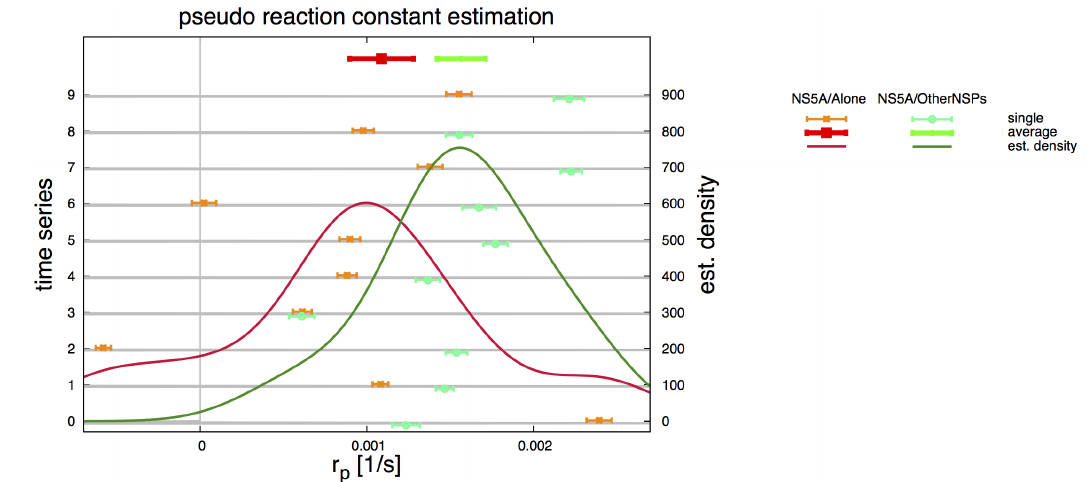
Figure 2. Averages for pseudo reaction rate r p —analyzed separately for NS5A/Alone (red— r A p ) and NS5A/OtherNSPs (green— r N p ). Thin points and error bars correspond to estimated values for r p (shown on x axis) for a single TMS (indicated on the left y axis). Aggregating over all TMS yields distributions (continuous lines, scale shown on right y axis). Thick symbols (shown on top) correspond to the averaged values r p reported in Section 2.5. The final averaged values r A p , r N p enter the diffusion equation of NS5A on the ER surface for the corresponding TMS of the two cell